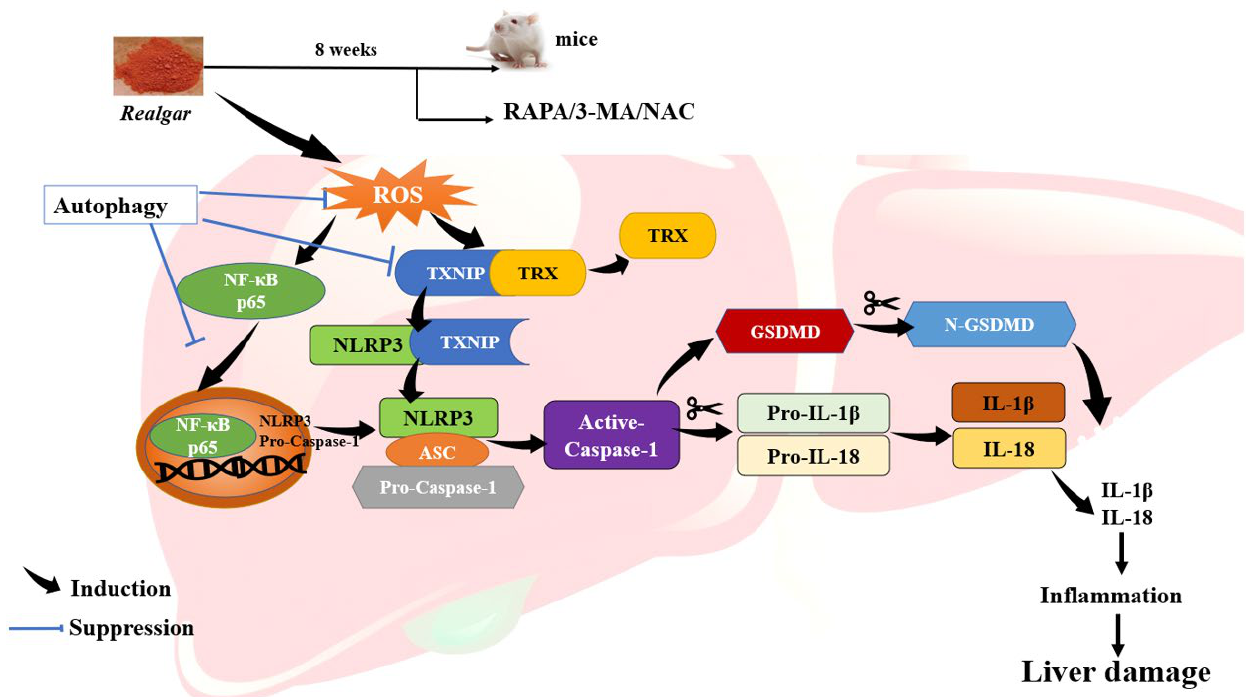
Figure 7. Proposed mechanism of the protective effect of autophagy on realgar-induced liver injury. Autophagy can alleviate realgar-induced liver injury via eliminating excessive ROS, inhibiting NF- κ B nuclear translocation and down-regulating TXNIP/NLRP3 axis, consequently inhibiting ROS-mediated NLRP3 inflammasome activation.